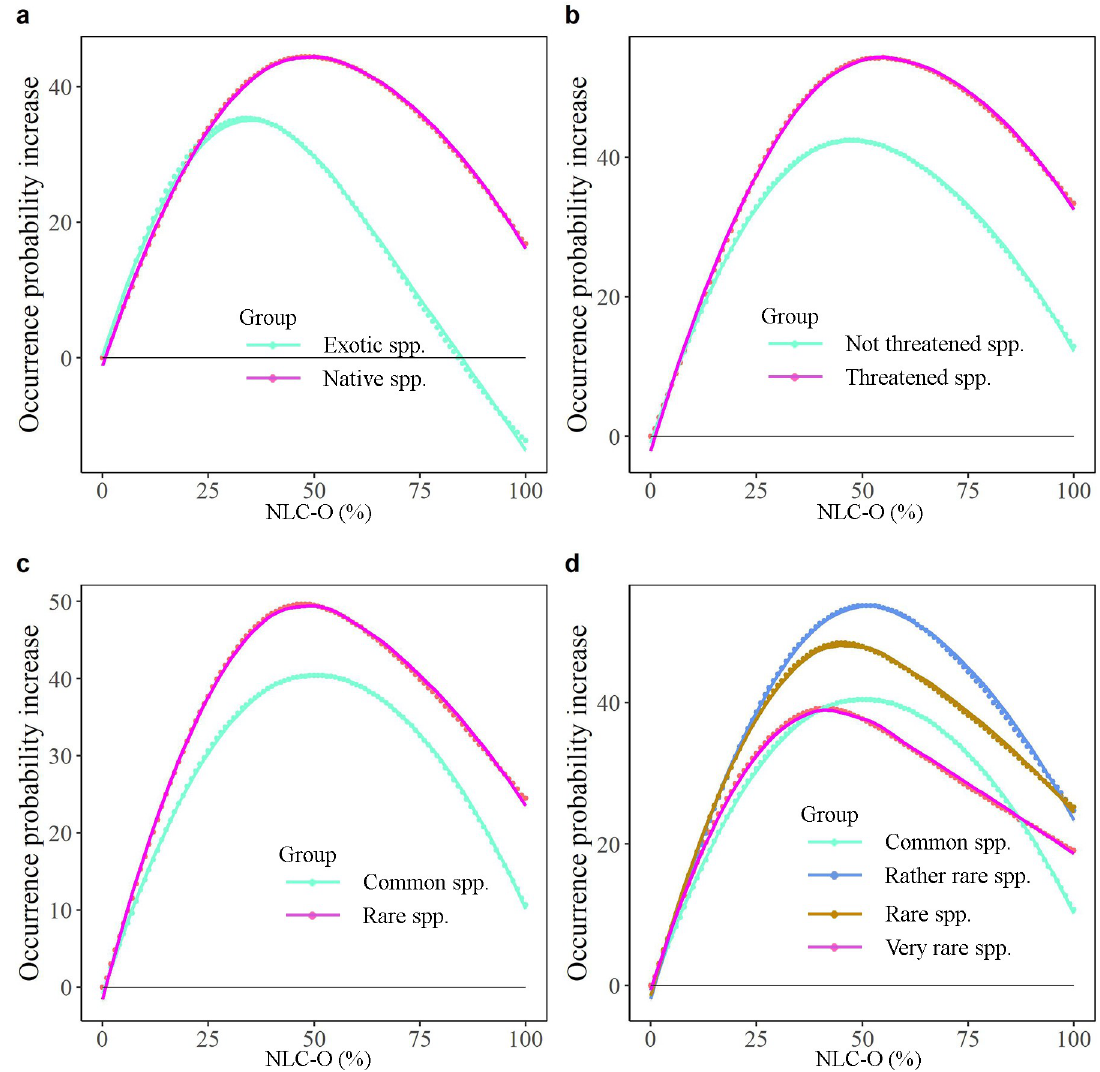
Fig 8. The average occurrence probability change (average occurrence probability change from 0% NLC-O to others, e.g. the NLC-O at 1x1 km resolution increases from 0% to 11%) of different species groups. a, all native species vs exotic species. b, threatened species vs not threatened species. c, rare species vs common species. d, Rare species vs common species, but rare species are classified into three categories (i.e. very rare, rare, rather rare) according to the Red List of Vascular Plants of the Netherlands [26]. Lines represent the best-fit